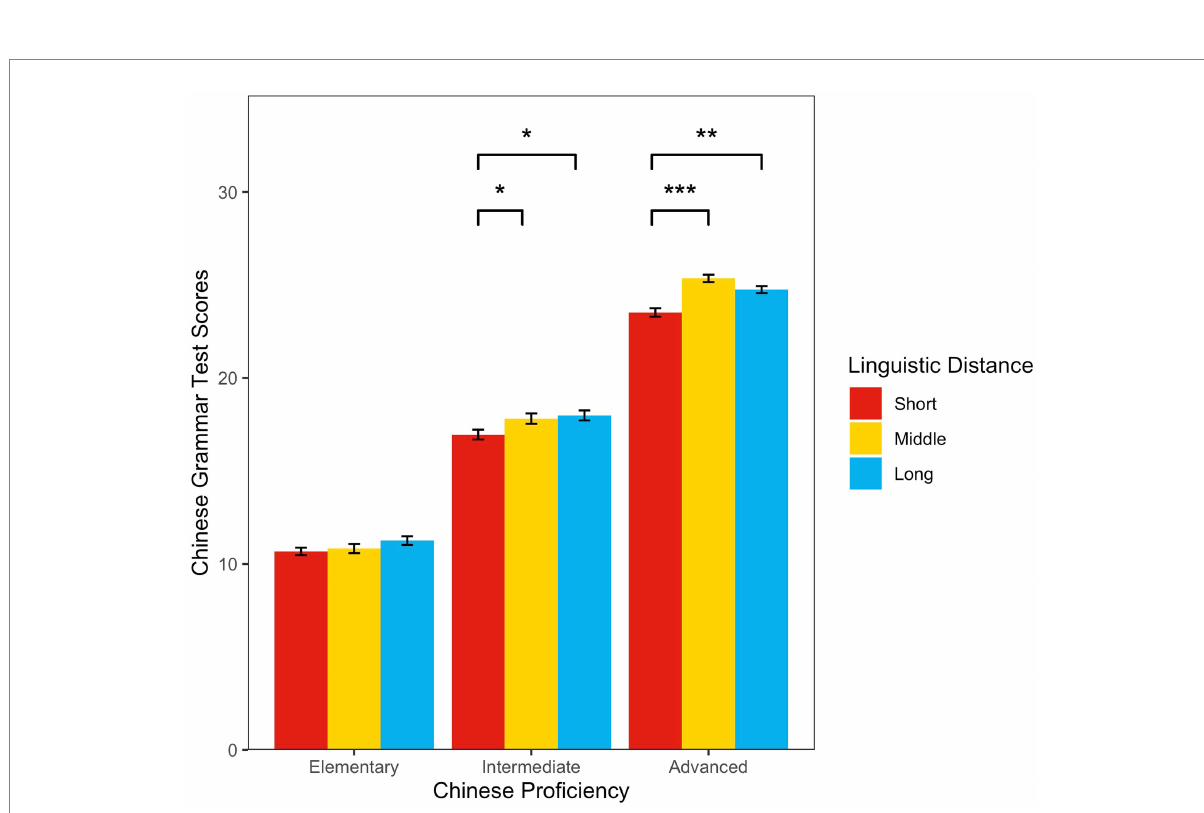
FIGURE 6 The relationship between Chinese proficiency, linguistic distance, and Chinese grammar test